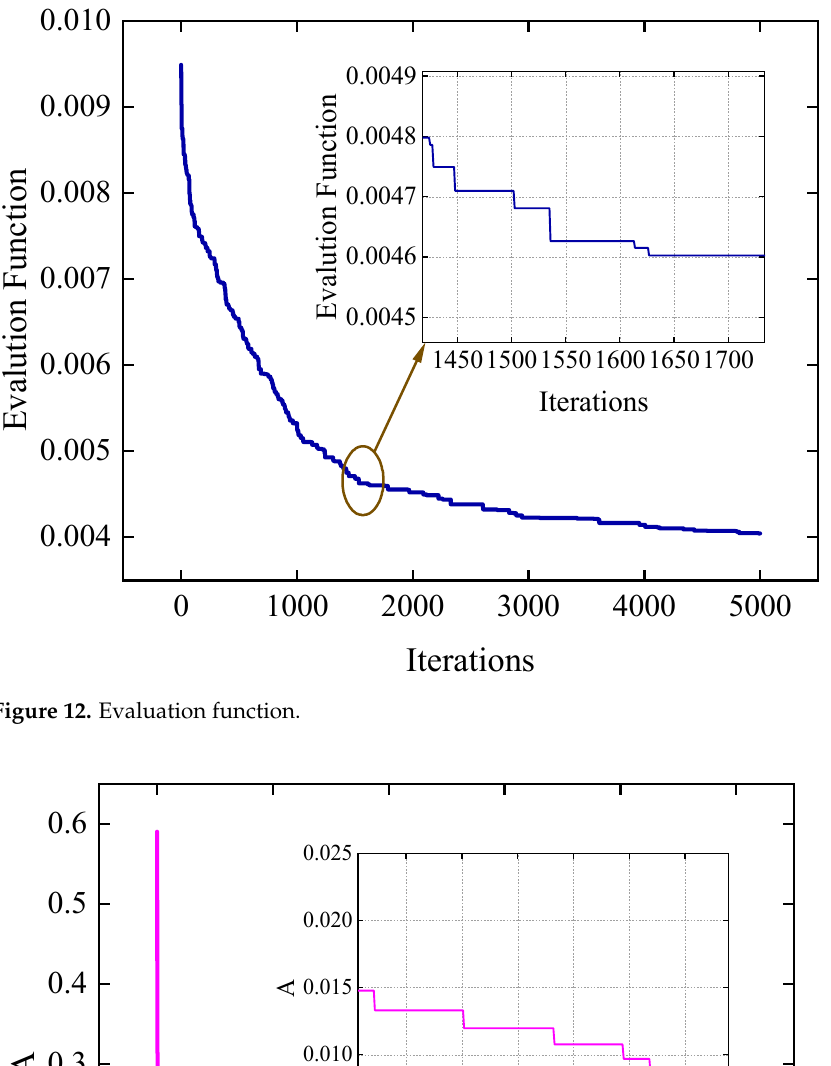
Figure 12. Evaluation function.